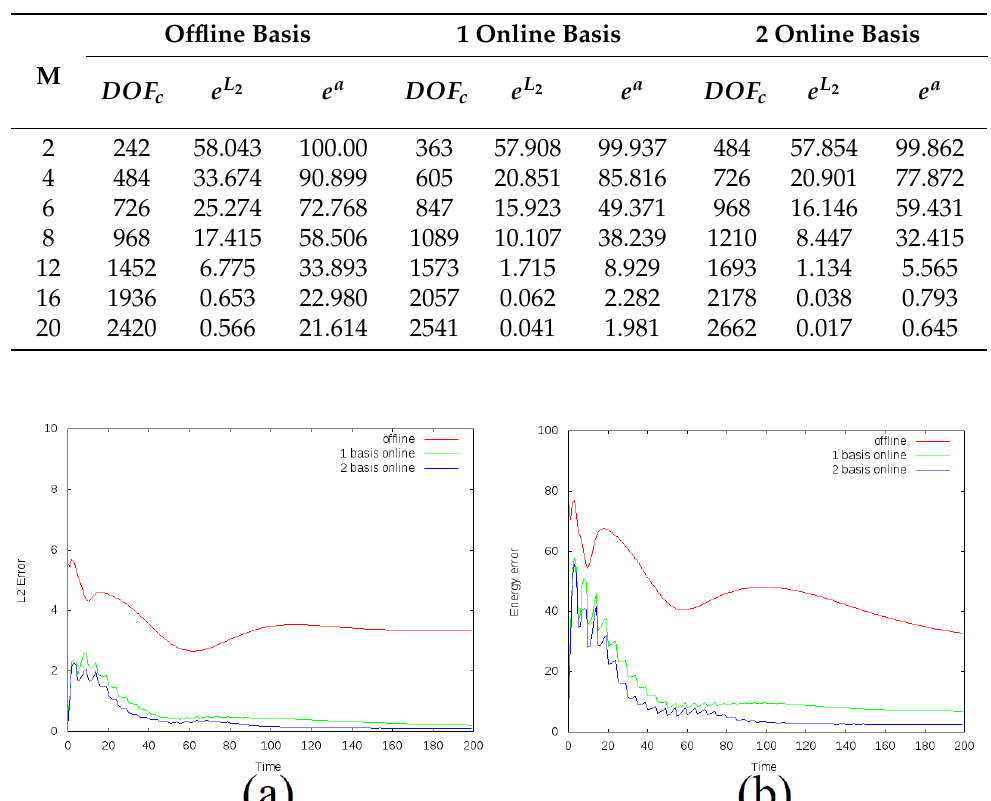
Table 3. Numerical results for Test 3 . Relative L 2 and energy errors (%) for different number of offline multiscale basis functions using 1 and 2 online basis functions on the last time layer.